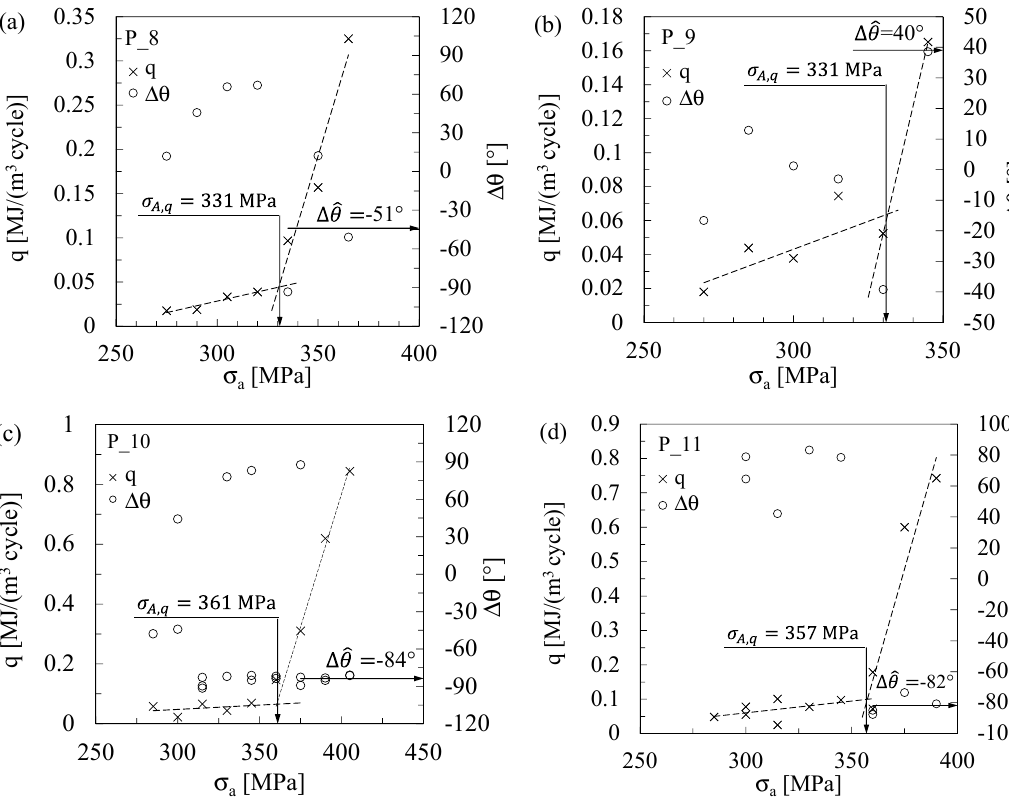
Figure 20. Step load-fatigue tests reanalyzed in terms of the q parameter (Equation (10)) and phase difference (Equation (12)) for ( a ) P_8, ( b ) P_9, ( c ) P_10, and ( d ) P_11 specimens.